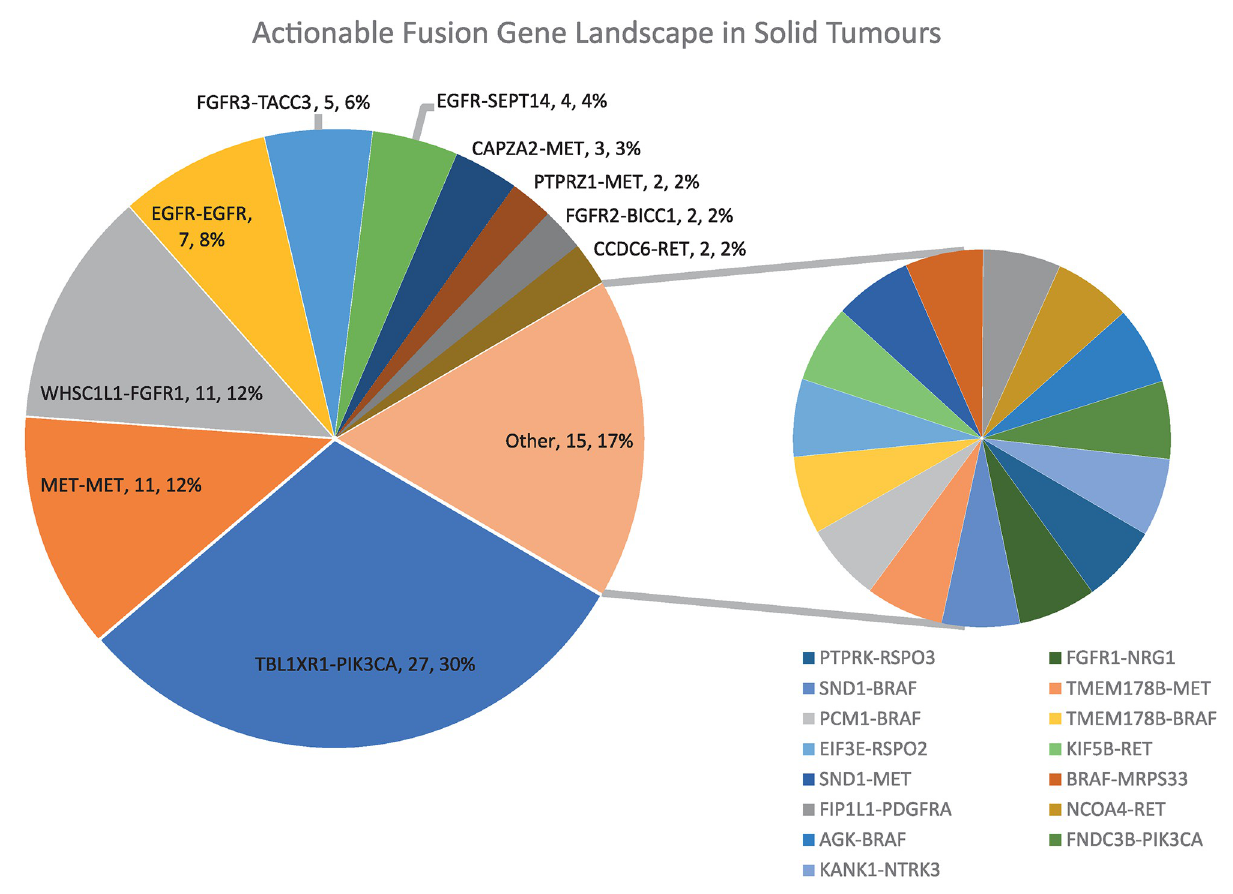
Fig 1. Actionable fusion gene landscape in solid tumours.